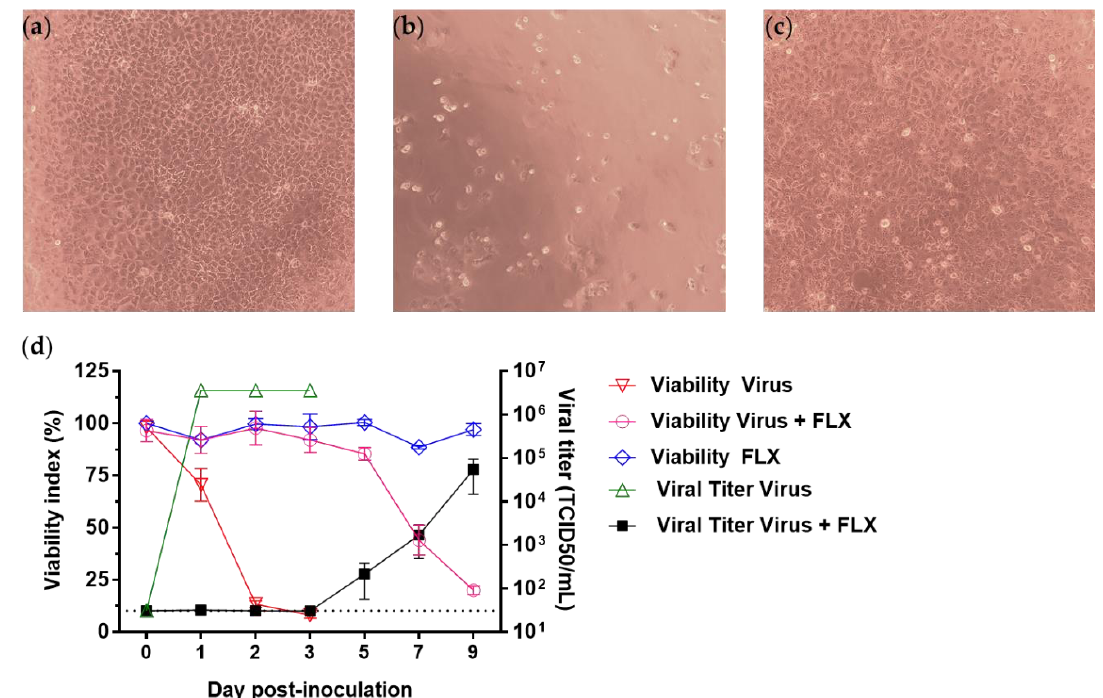
Figure 3. Levels of infectious particles in supernatants of SARS-CoV-2-infected Vero E6 cells treated daily with Fluoxetine (FLX). Cytopathic effects due to SARS-CoV-2 (MOI 0.01) in Vero E6 cells: ( a ) uninfected Vero E6 cells, ( b ) SARS-CoV-2- infected Vero E6 cells, ( c ) SARS-CoV-2-infected Vero E6 cells treated with 10 μM of FLX. The cells were observed under an inverted microscope (magnification ×100) after 72 h of incubation. ( d ) Vero E6 cells were inoculated with SARS-CoV-2 (MOI 0.01) and treated with 10 μM of FLX. After incubation for 2 h, the cells were washed three times with complete medium and then 10 μM of FLX was added. Cells were treated daily from day 1 to day 7 post-inoculation with 10 μM of FLX. Cell viability was evaluated using the Orangu assay (inverted gray triangles, white circles, dark gray diamonds) and levels of infectious particles in the supernatants were determined using the endpoint dilution assay (gray triangles and black squares) from day 1 through day 9 post-infection. The Spearman–Karber method was used to determine the tissue culture 50% infectious dose (TCID 50 /mL). The results are presented as the mean ± SD of three independent experiments.